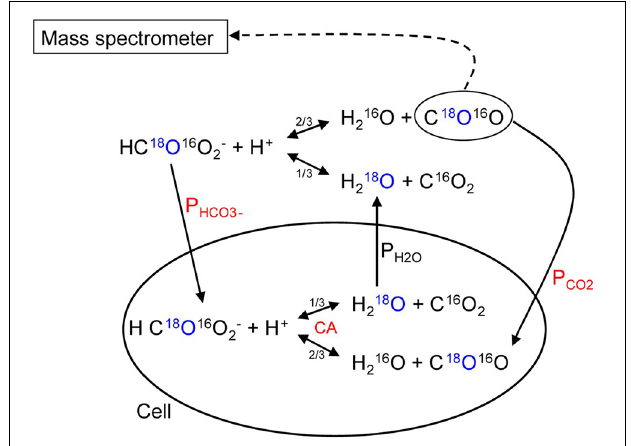
FIGURE 8 | Schematic representation of the processes occurring when carbonic anhydrase-containing cells are added to 18 O-labeled CO 2 -HCO − 3 solution. The labeled O is marked in blue, the most critical parameters determining the time course of the process are labeled in red. Single arrows indicate transport processes, double arrows reaction processes.